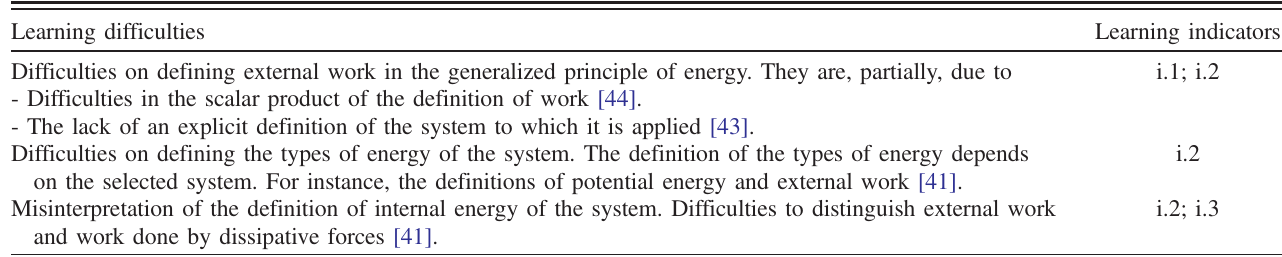
TABLE II. Learning demands for the three learning indicators defined in Table I. Learning difficulties